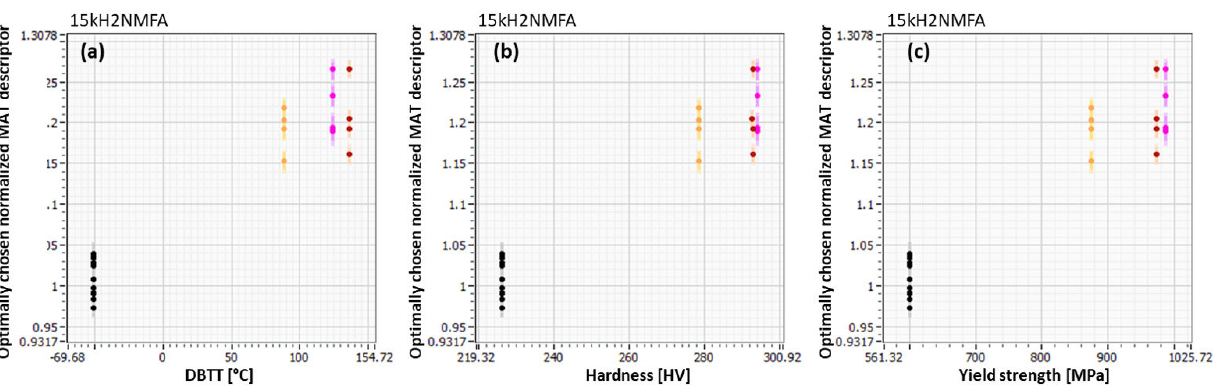
Figure 16. Dependency of the MAT descriptor on the DBTT ( a ), hardness ( b ), and yield strength ( c ) of eastern RPV material